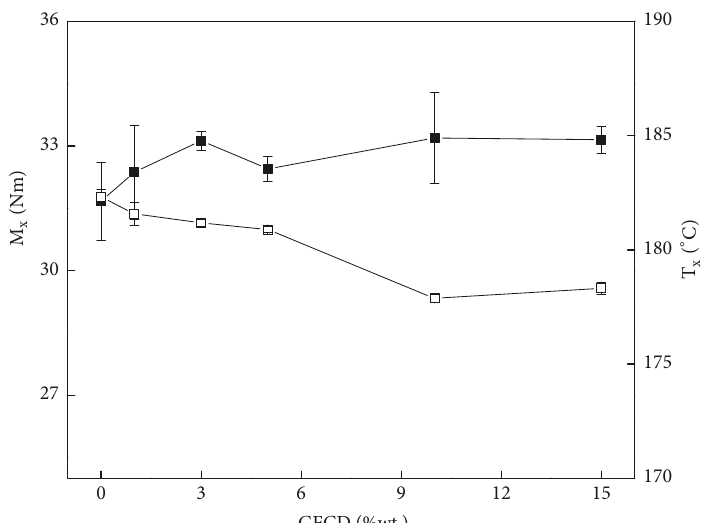
Figure 3: Torque at the fusion point M GFCD content in PVC.